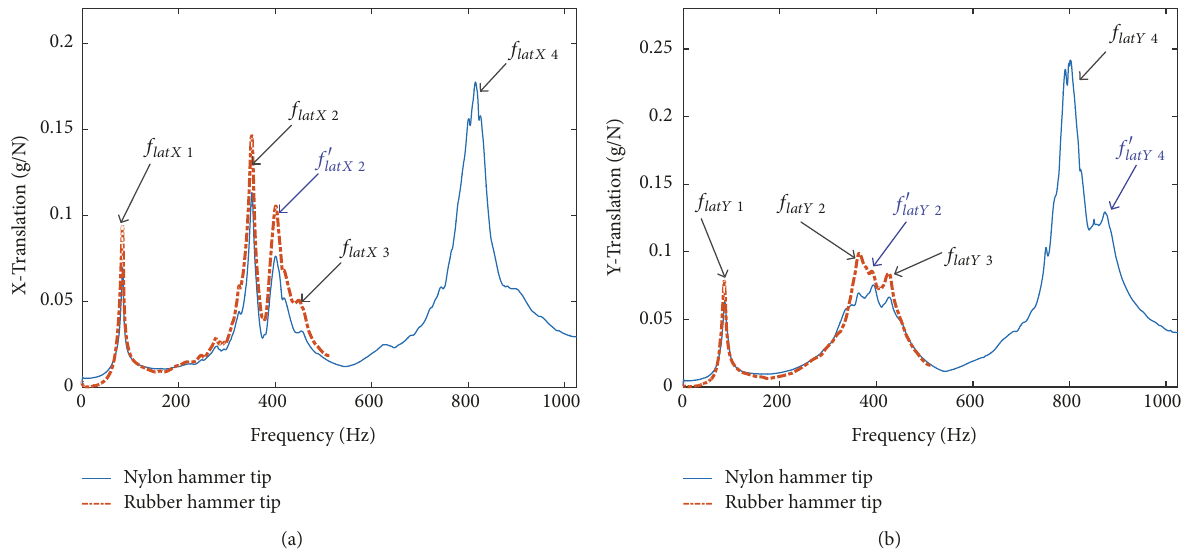
Figure 18: Frequency response of lateral vibration: (a) 𝑋 direction sum FRFs, and (b) 𝑌 direction sum